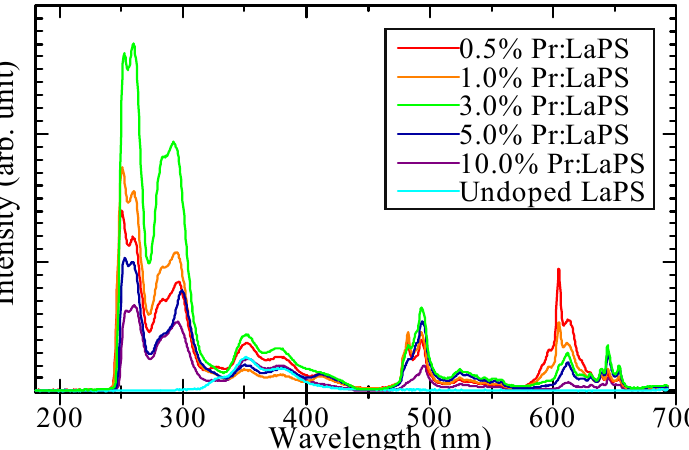
Figure 6. X-ray-induced scintillation spectra of the Pr-doped LaPS and the undoped LaPS. The X-ray-induced scintillation decay time profiles of the Pr-doped LaPS samples and approximation formula of each sample are presented in Figure 7. The decay time profile of